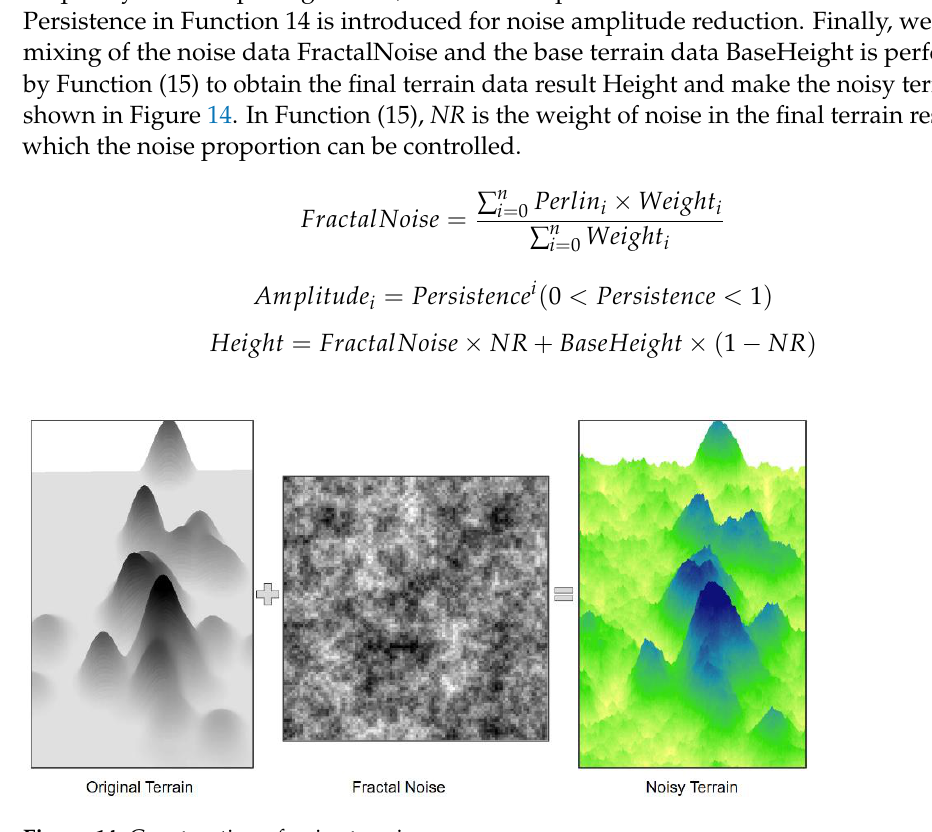
Figure 14. Construction of noisy terrain.